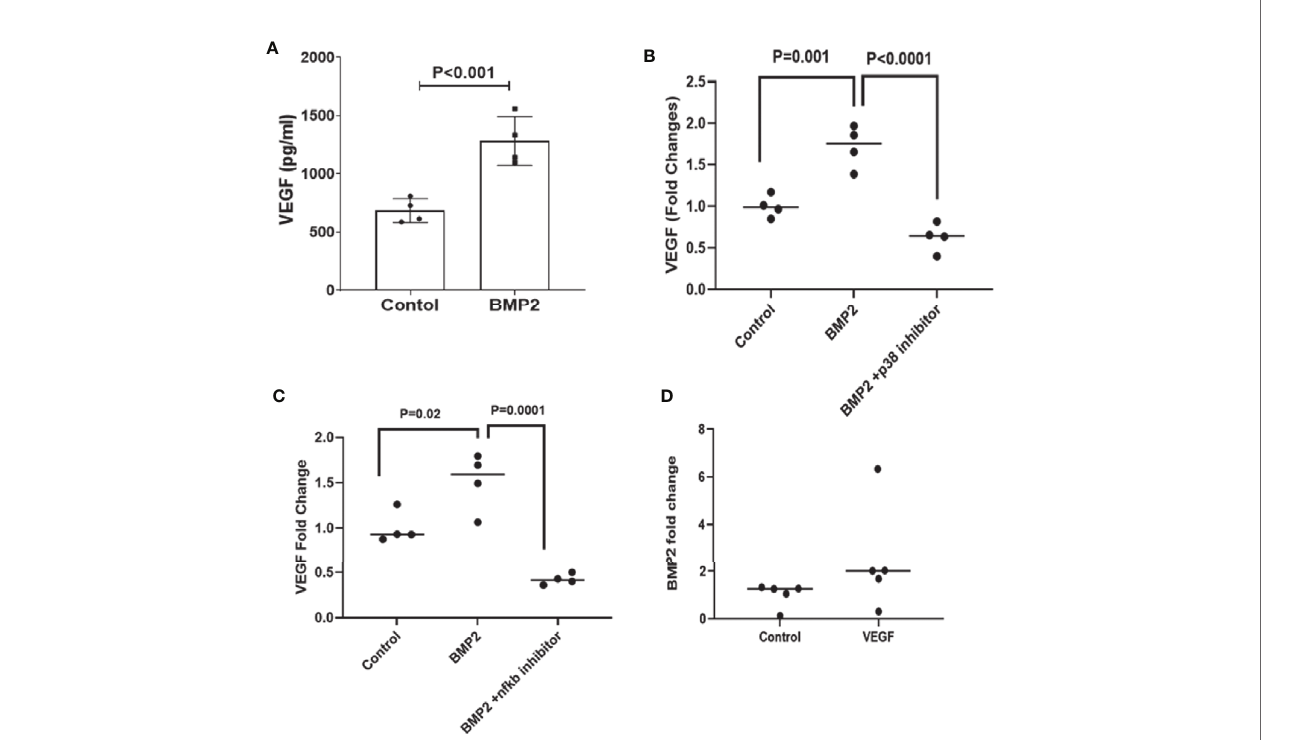
FIGURE 4 | ELISA of VEGF and BMP levels lin human retinal endothelial cells (HRECs). One-way ANOVA followed by a post hoc Tukey ’ s test was used to compare the effect of BMP2 on VEGF levels in the presence or absence of p38 or NF k b inhibitors in cultured HRECs. Data analysis are showing signi fi cant increases in the expression of VEGF by BMP2 (50ng/ml) treatment for 24 h compared to the control (A). This increase is inhibited by p38 inhibitor (SB202190, 10 m M) (B) or NF k B inhibitor (JSH23, 20 m M) (C) . Furthermore, ELISA of BMP2 levels in the condition medium of VEGF-treated HRECs is showing a signi fi cant increase by VEGF (30ng/ml for 24 h) compared to the control (D) . Analysis of the difference between control and VEGF treatment was done using unpaired